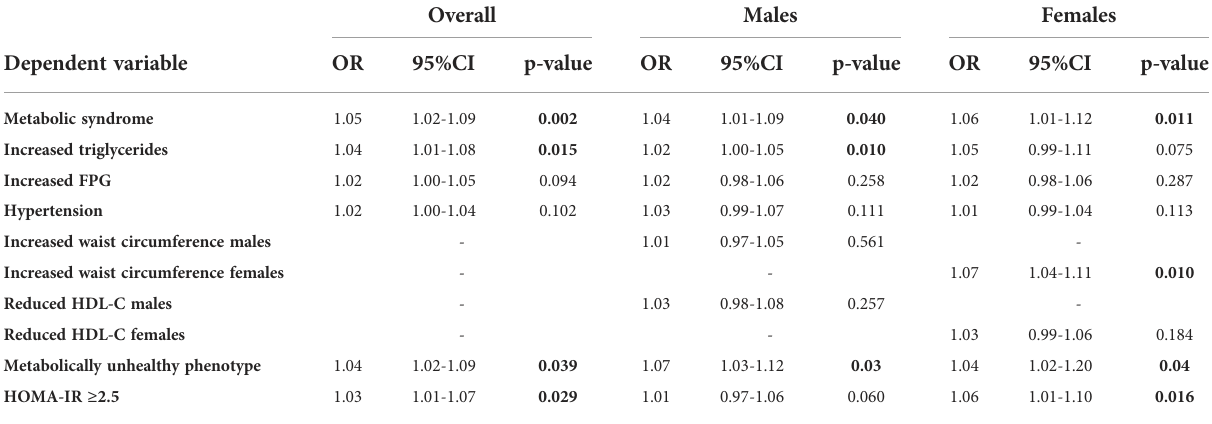
TABLE 3 Results of age adjusted binary logistic regression analysis between mtDNA copy number and metabolic syndrome, its individual components, the metabolically unhealthy phenotype [based on the empirical de fi nition by Zembic et al ] and HOMA-IR ≥